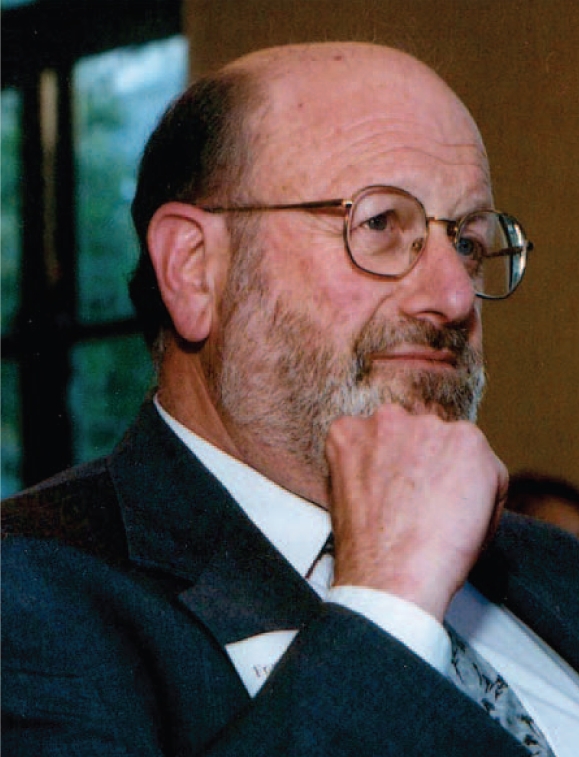
Frank E. Speizer